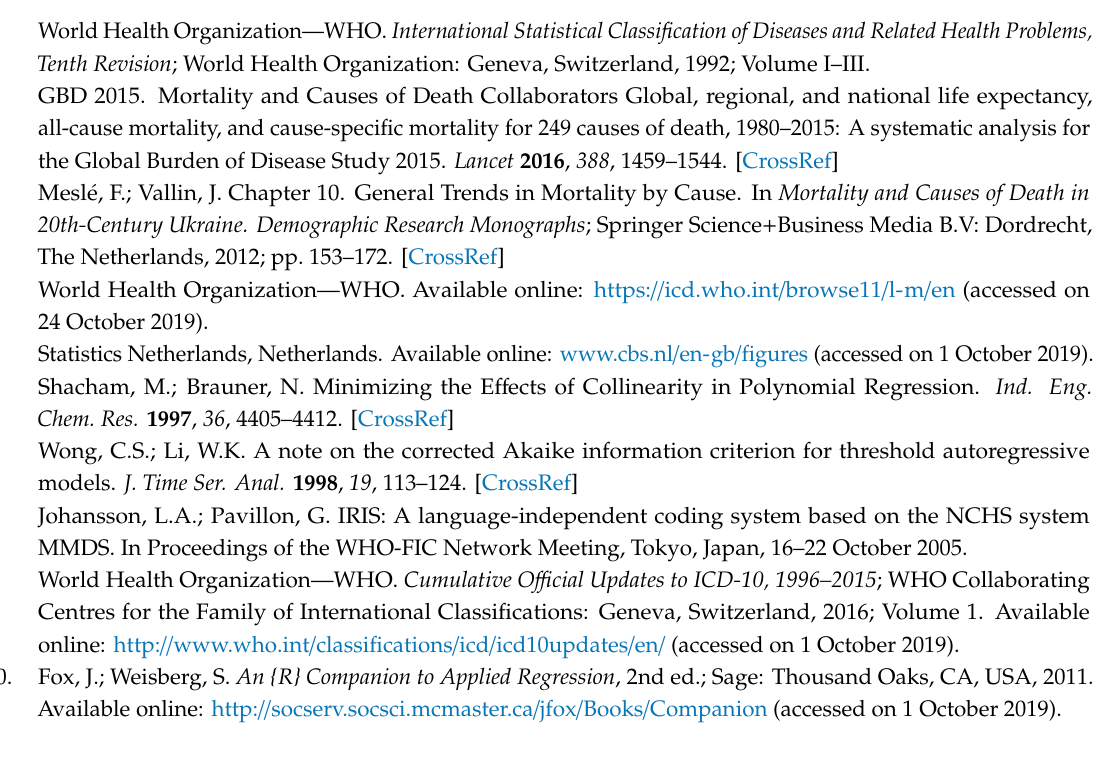
Table S1: Age-standardized count of deaths for the three position ICD-10 codes reported in the Netherlands, for the period 1996–2015. Table S2: Detailed long-term trend patterns for the 625 three position ICD-10 codes with at least three average annual deaths as individual causes, or aggregated per block and